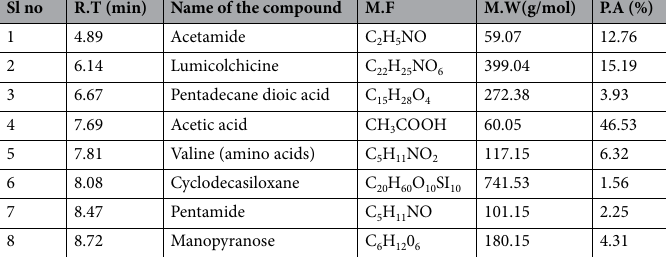
Sl no R.T (min) Name of the compound